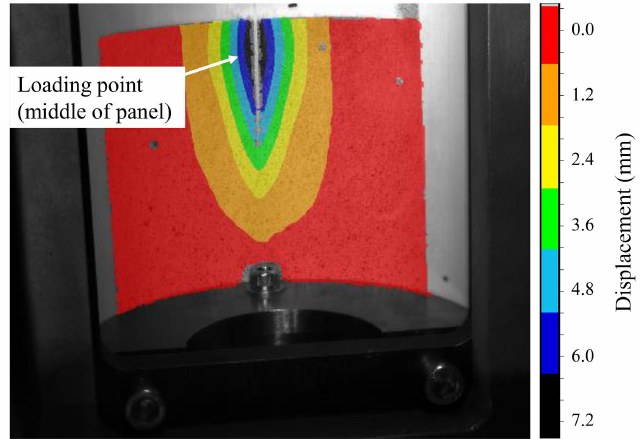
Figure 8. The mechanical testing of a panel specimen: the DIC-resolved displacement field during the indentation loading of the half-circular specimen at the moment of maximum